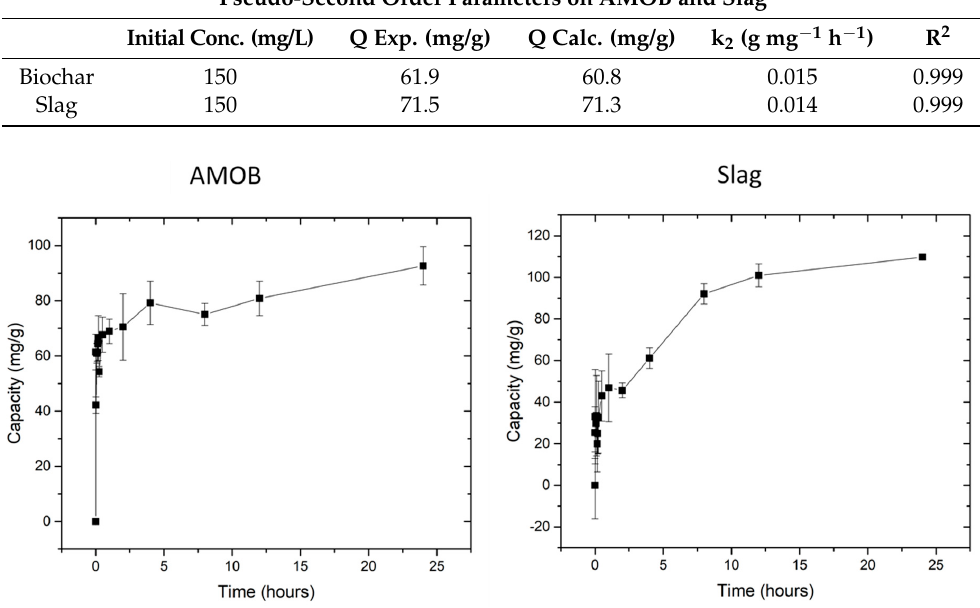
Figure 7. Biochar reached equilibrium within 30 min. Slag reached equilibrium within 8 h. [pH = 5.0; adsorbent concentration = 0.002 g/mL; 500 mg/L PO 43 − solution; shaking time 24 h]. Table 2. Pseudo-second order parameters for phosphate adsorption [pH = 5.0; adsorbent dose = 1.0 g/L; 150 mg/L PO 43 − ; 25 °C; 150 rpm shaking] .